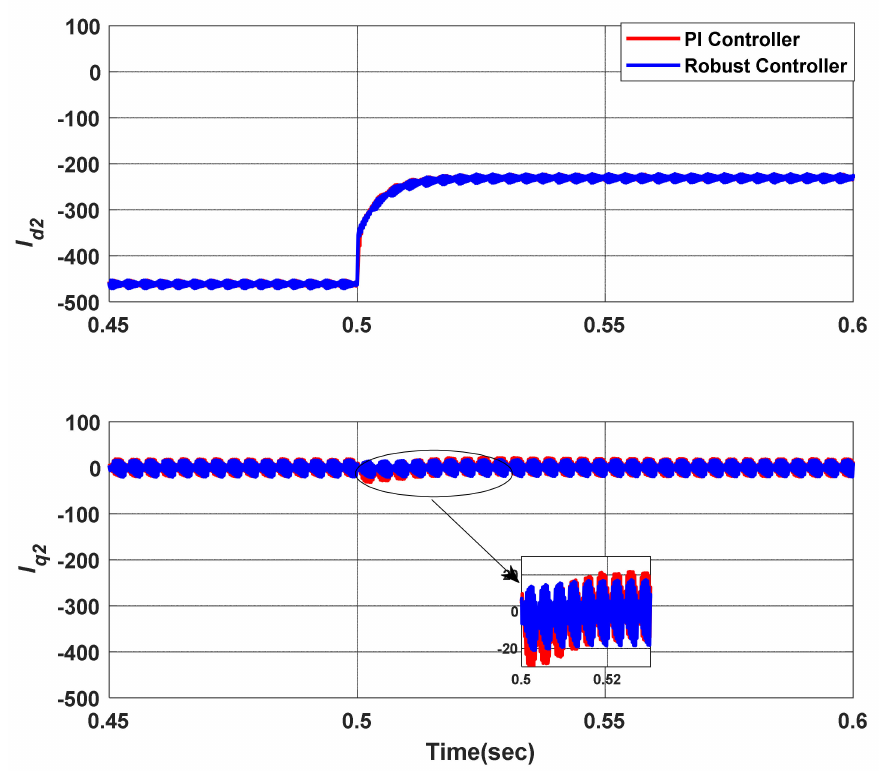
Figure 15. I d2 and I q2 for the nominal case for a 50% step change in active